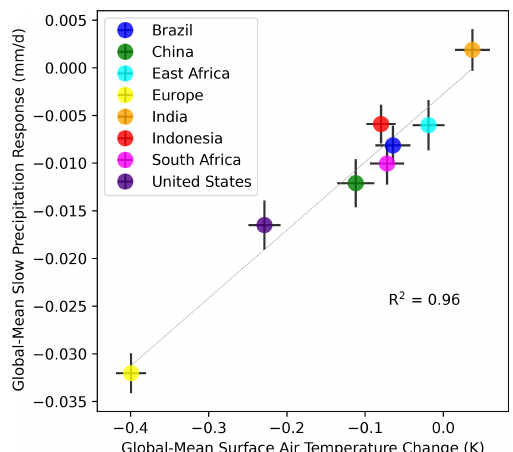
Figure A3. As in Fig. 2b but for the second simulation set conducted with adjusted initial conditions (see Sect. 2).